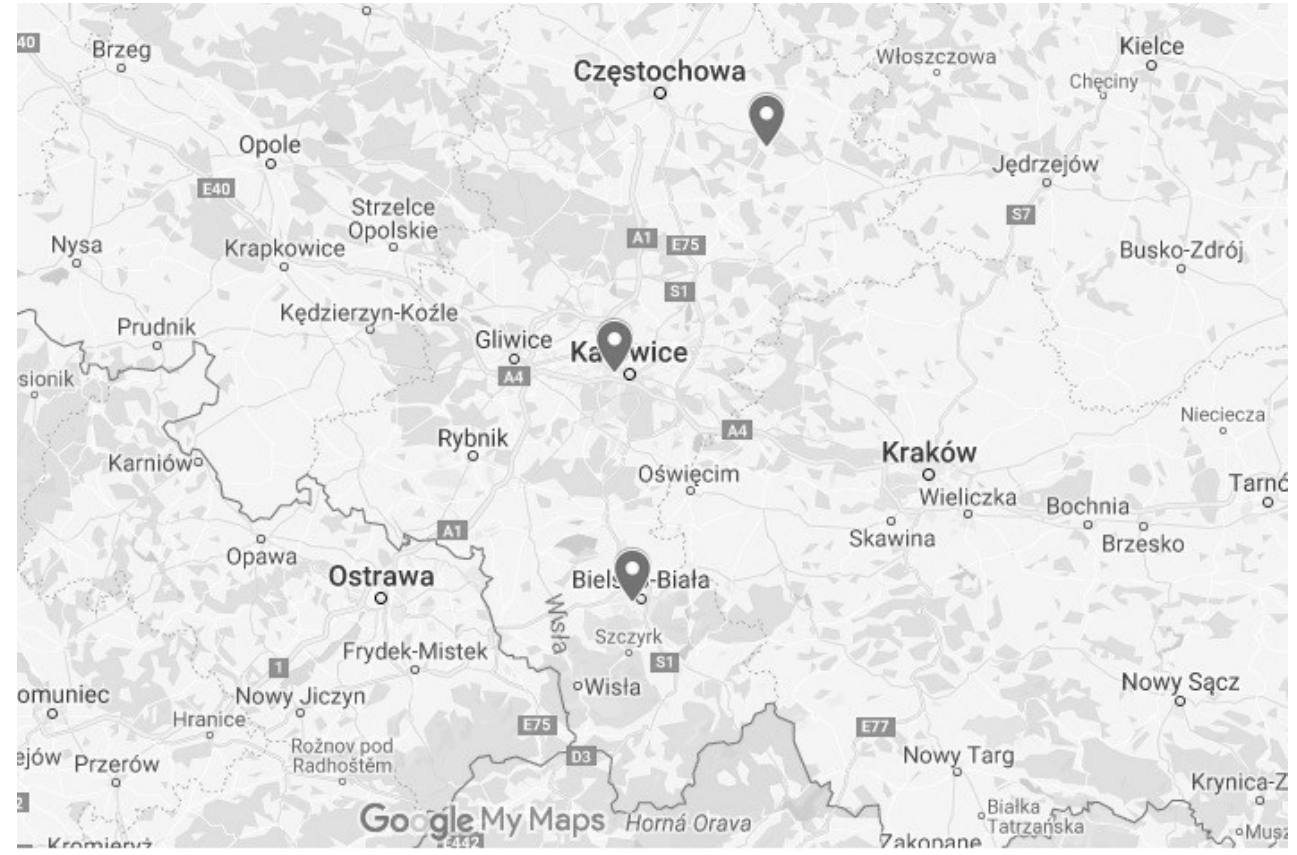
Figure 1. Map. The locations of measurement sites in Bielsko-Biała, Katowice and Zloty Potok in the Upper Silesian agglomeration used in the study.